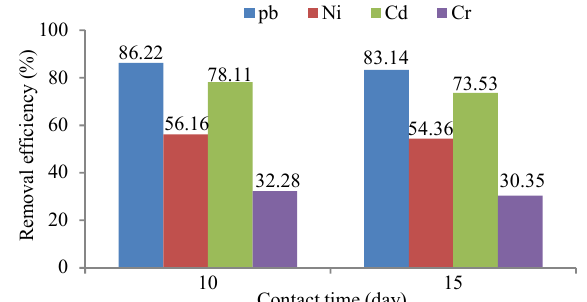
Fig. 6. Duckweed efficiency in separate heavy metal removal at concentration of 25 mg/l (duckweed weight: 0.4